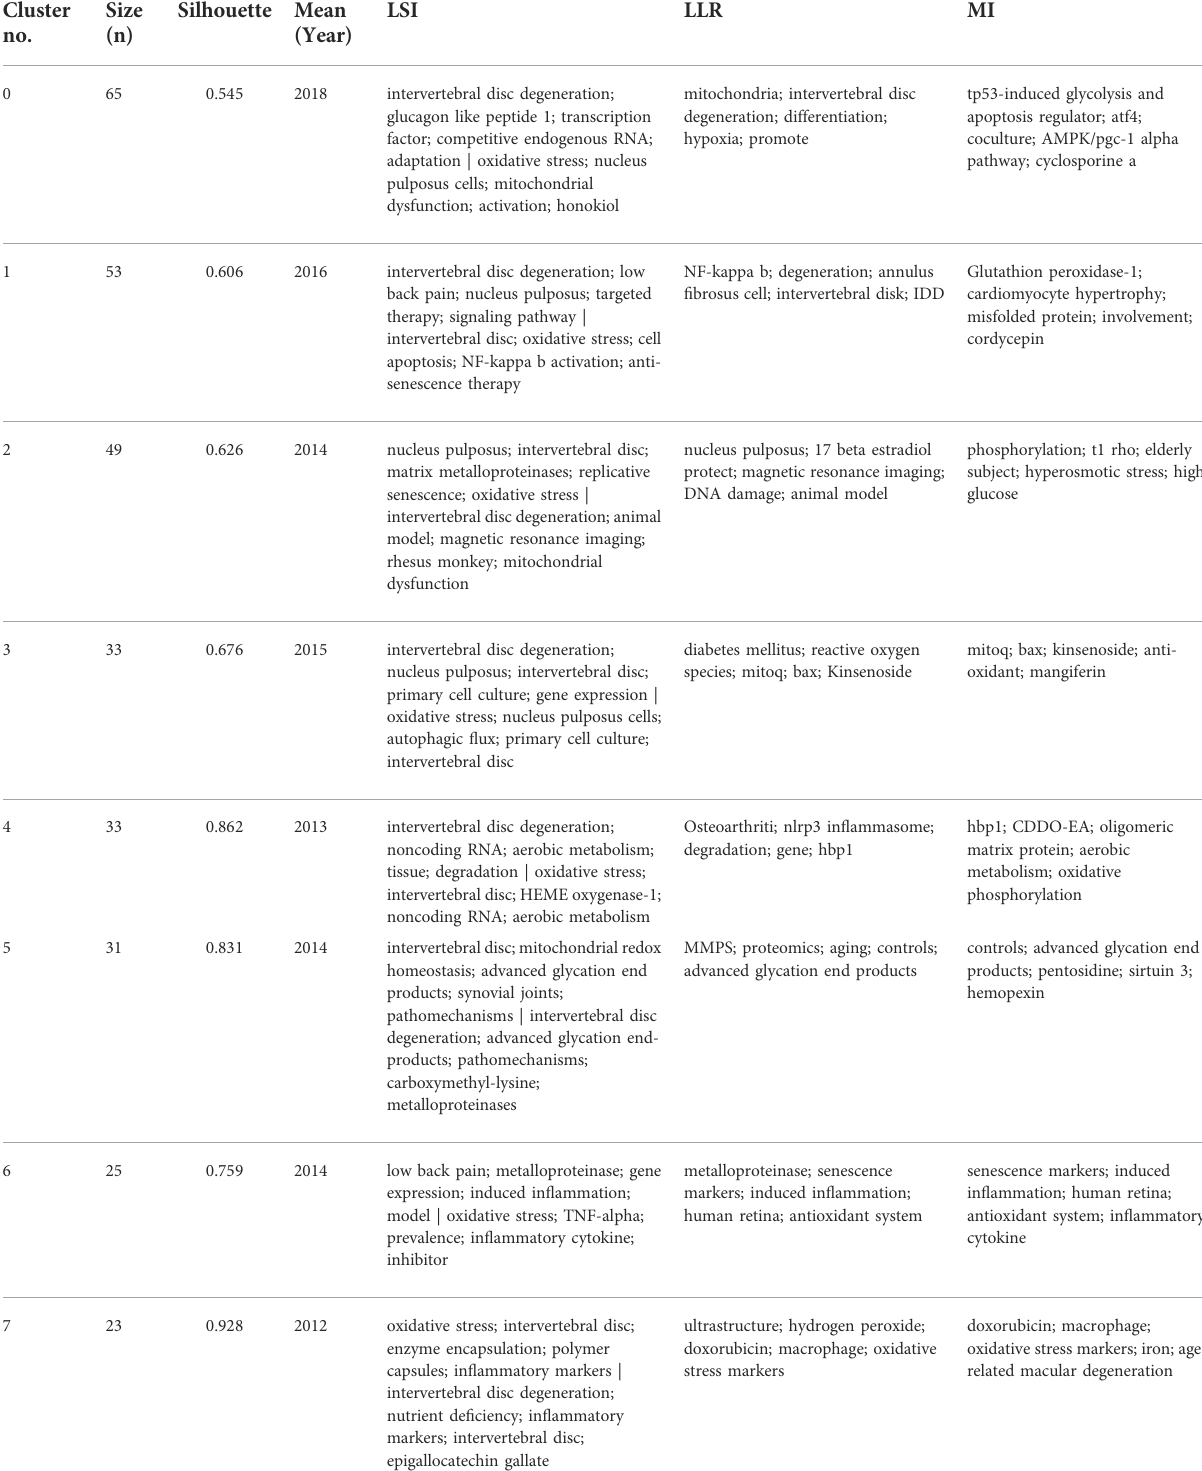
TABLE 6 Details of top 10 clusters for researches on oxidative stress in intervertebral disc degeneration from 2007 to 2021. Cluster